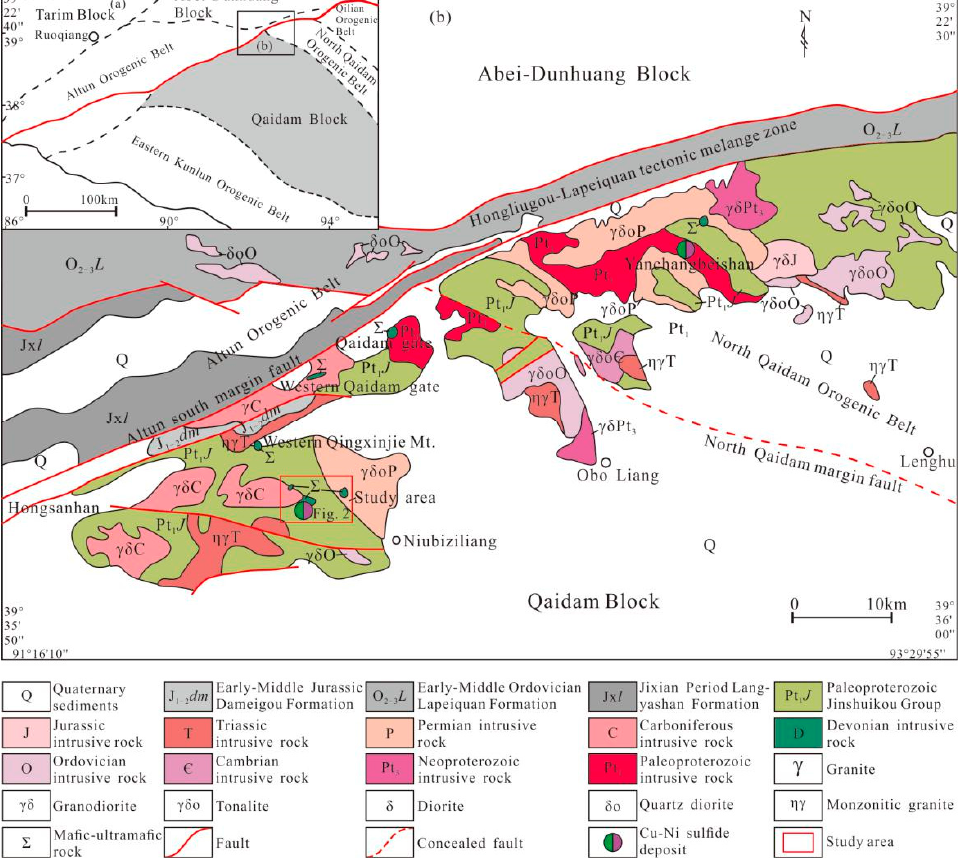
Figure 1. Structural location map ( a ) and geological sketch map ( b ) of the northern margin of Qaidam Basin (modified after Qian et al. (2015) [15]).